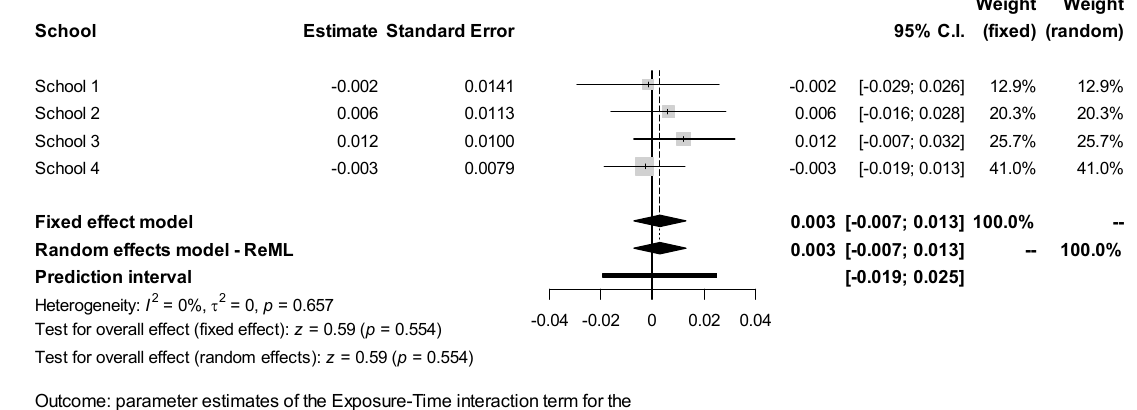
Figure 2. Meta ‐ analysis for test response test score.